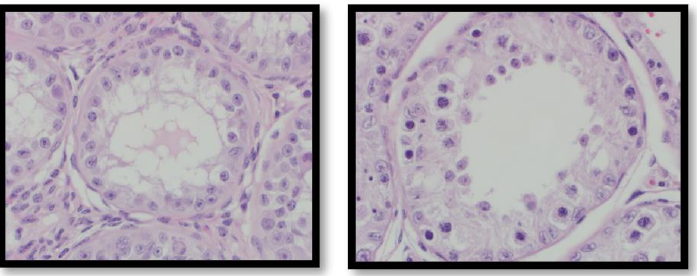
Figure 2. Representative examples of seminiferous tubules, showing an Ottesen score of 3 with only spermatogonia (left) and 6 with several spermatids (right). spermatogonia ( left ) and 6 with several spermatids ( right